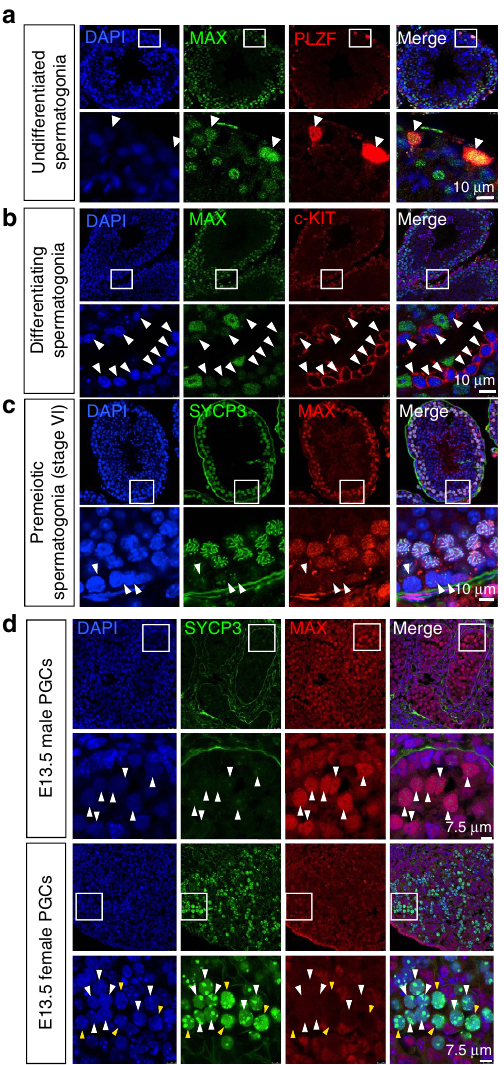
Figure 9 | Max expression dynamics in normal gametogenesis. Frozen sections of testes from adult male mice were prepared and immunostained for MAX. The sections were also co-immunostained for PLZF ( a ), cKIT ( b ) or SYCP3 ( c ). Arrowheads in a , b and c indicate PLZF-positive undifferentiated spermatogonia that are strongly positive for MAX, cKIT- positive differentiating spermatogonia that are weak for MAX and cells undergoing meiotic cell division (presumable premeiotic type B spermatogonia) that are weak for both SYCP3 and MAX, respectively. ( d ) Decline of MAX expression levels in female, but not in male, PGCs of 13.5 dpc embryos. Male and female embryos (13.5 dpc) were recovered from a single pregnant female mouse, and then the genital ridges were recovered individually. After processing, sections were prepared and subjected to co-immunostaining with antibodies against MAX and SYCP3. Arrowheads shown in male genital ridges represent PGCs with strong and weak signals for MAX and SYCP3, respectively. Corresponding female PGCs with strong expression of SYCP3 are also indicated by arrowheads in which white and yellow indicate weak and almost no MAX expression,